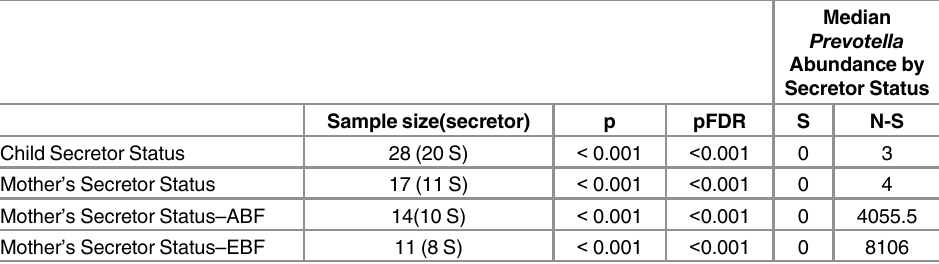
Results of DESeq2 analysis (total sample size (number of secretors), DeSeq2 calculated p value, Benjamini- Hochberg adjusted p values (pFDR) and median absolute count of Prevotella) of association of Prevotella abundance by child secretor status, mother secretor status, mother secretor status — ABF (Any Breast- Feeding) subgroup, with the 2 formula-fed children excluded, and mother secretor status — EBF (Exclusively Breast-Fed) sub-group, containing only children who had been exclusively breast-fed for at least 4